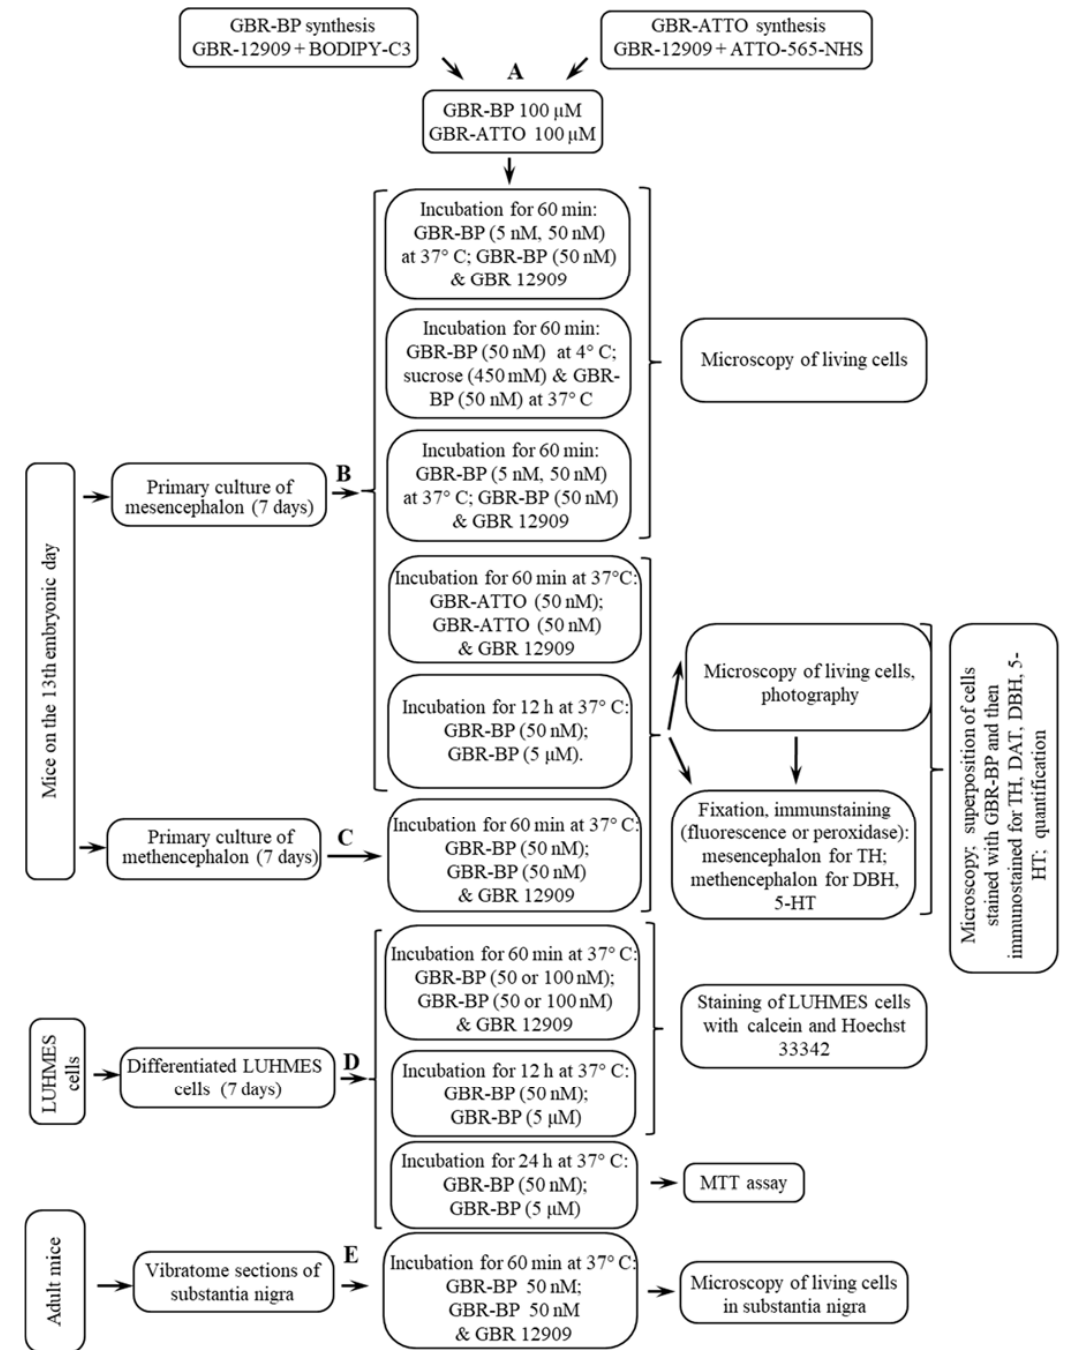
Figure 11. Design of experiments on cells of a primary culture of the mouse embryonic mesencephalon and metencephalon, the immortalized cells of the human mesencephalon (LUHMES) after differentiation, as well as on vibratome sections of the substantia nigra of adult mice: ( A ) GBR ‐ BP and GBR ‐ ATTO synthesis; ( B ) staining of mesencephalic living cells with 1 ‐ (2 ‐ (bis(4 ‐ fluorophenyl)methoxy)ethyl) ‐ 4 ‐ (3 ‐ phenylpropyl)piperazine–BODIPY (GBR ‐ BP) and GBR ‐ ATTO; ( C ) staining of metencephalic living cells with GBR ‐ BP; ( D ) staining of living LUHMES cells with GBR ‐ BP; ( E ) staining of nigral living cells with GBR ‐ BP. Fixation of GBR ‐ BP ‐ prestained cells and immunostaining for proteins—markers of dopaminergic, noradrenergic, and serotonergic neurons: tyrosine hydroxylase (TH), dopamine ‐β hydroxylase (DBH), and 5 ‐ hyroxytryptamine (5 ‐ HT) (serotonin), respectively.